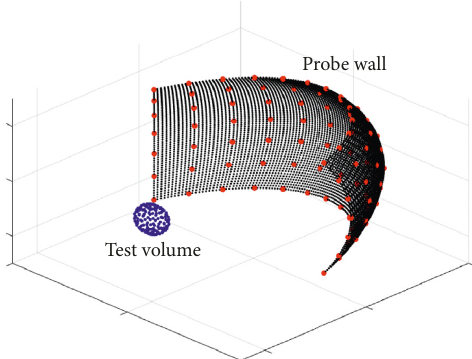
Figure 2: Sectorized MPAC OTA setup. The black spherical surface denotes the probe wall, and each red dot on the probe wall denotes a probe antenna. The volume enclosed by blue dots denotes the test volume. Note that the test volume is enlarged for better